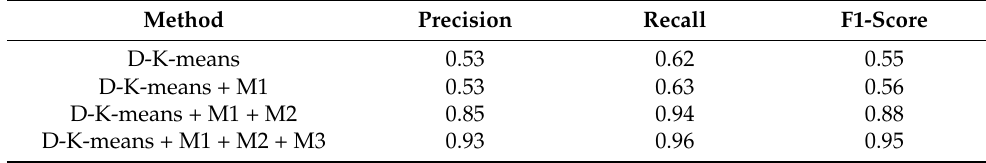
Table 1. Comparison of step by step results of the trajectory recognition algorithm.